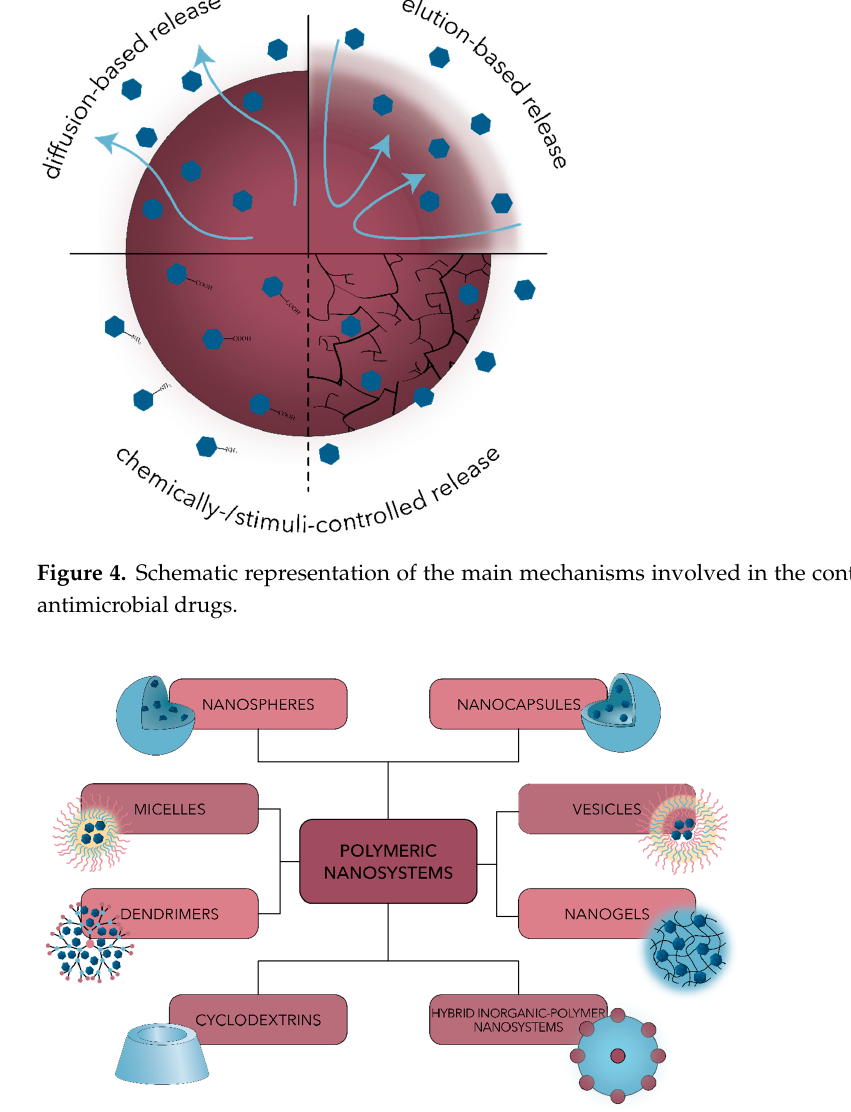
Figure 5. Schematic representation of the main types of polymeric nanosystems used for antimicrobial drug delivery.